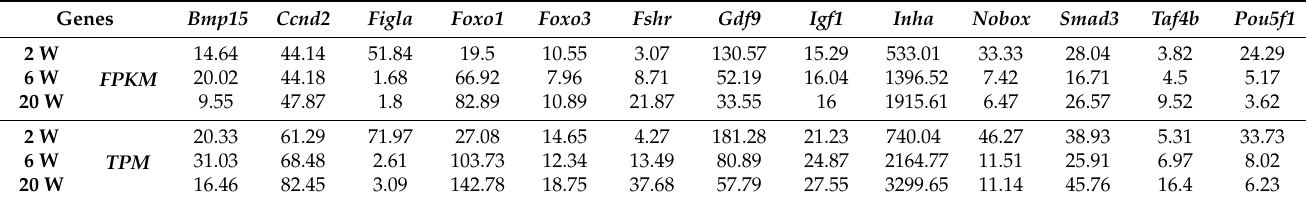
Table 4. Key regulatory genes expressed in the reproductively-aged mouse ovary, analyzed by FPKM and TPM. Genes